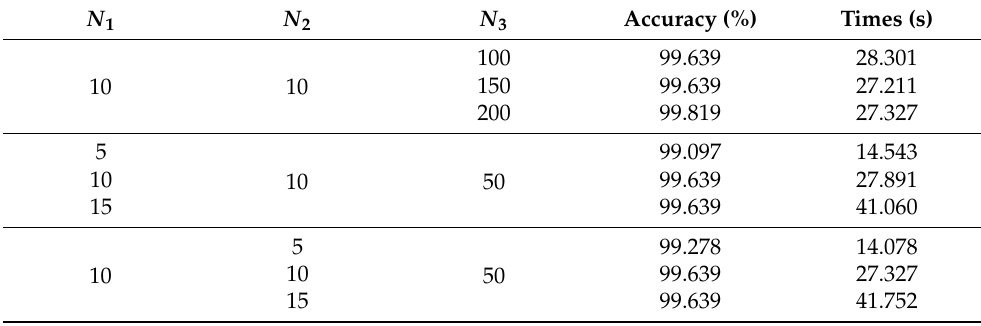
Table 4. Comparison of the results of the CBNLM-BLS for damage images of the wind turbine blade on the collected image dataset when taking different